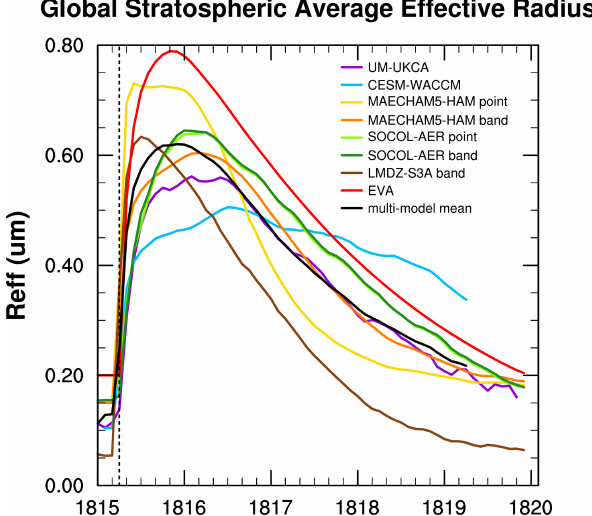
Figure 3. Global stratospheric mean effective radius ( R eff ) time se- ries. Vertical dotted line marks date of injection of SO 2 . The calcu- lation of R eff is weighted by surface aerosol density and grid cell volume, as explained in Appendix